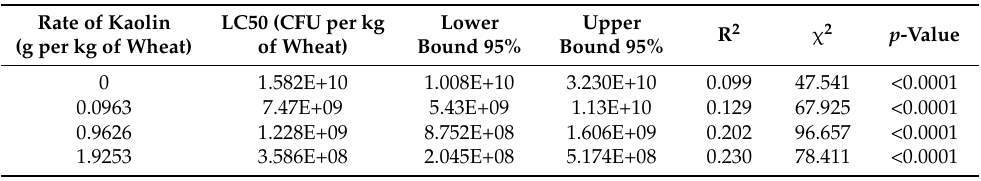
Figure 2. Bioassay 2: Percentage mortality of Oryzaephilus surinamensis adults exposed to different rates of Beauveria bassiana IMI389521 and different rates of kaolin after 14 days of exposure (Mean ± SE). Table 2. Results of logistic regression on Oryzaephilus surinamensis mortality data for each rate of kaolin in dose response bioassay 2.